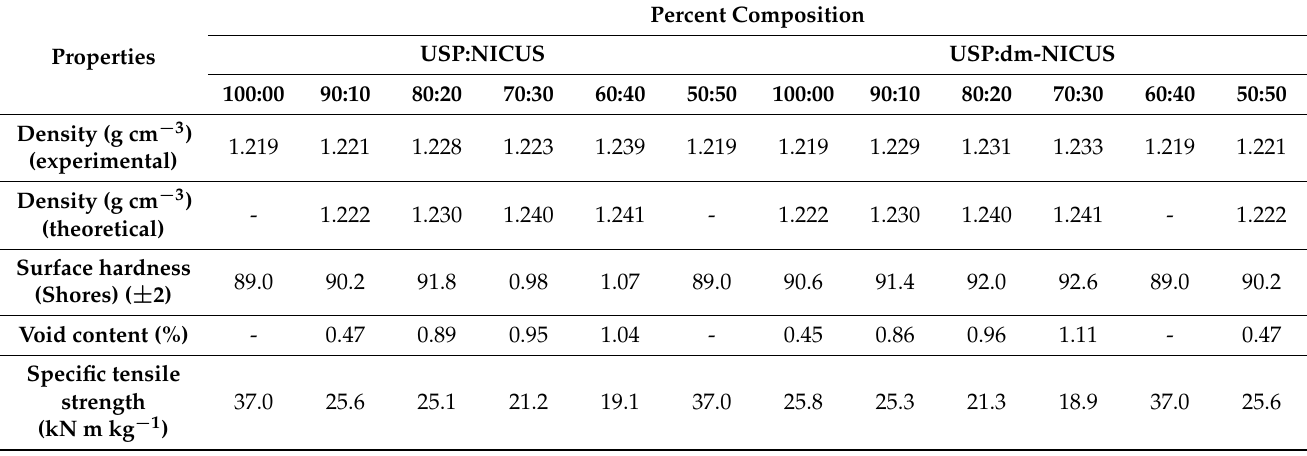
Table 10. Physicomechanical properties of unsaturated polyester thermoset composites.